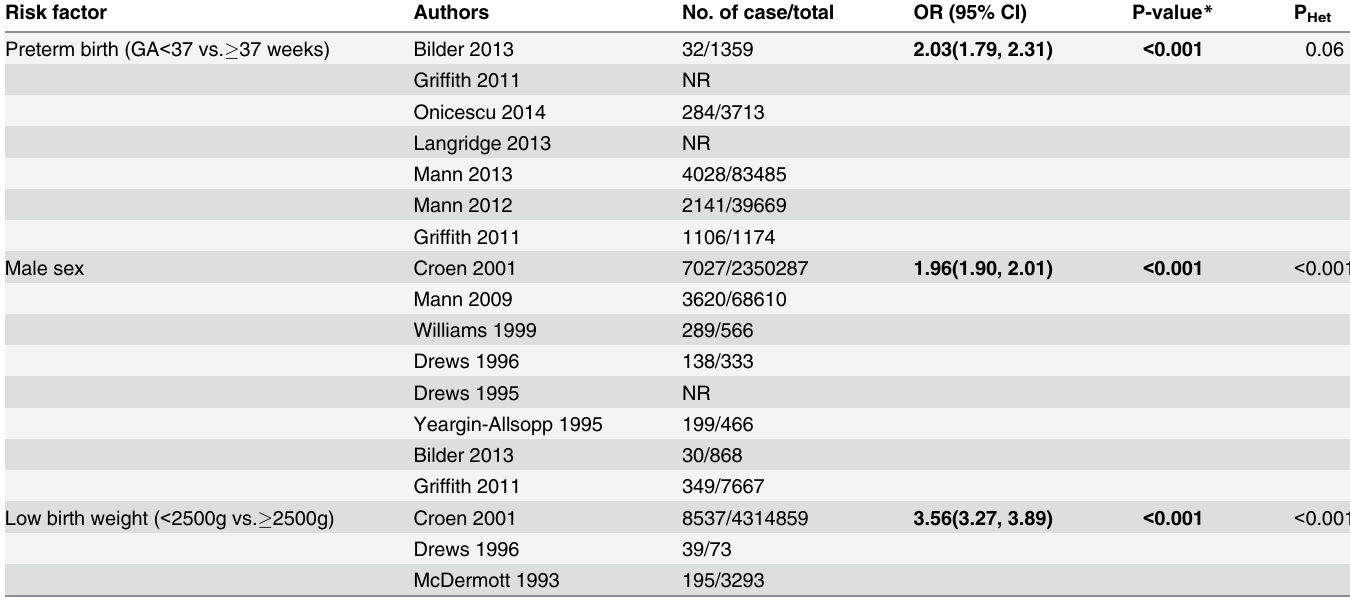
Table 4. Meta-analysis of peri- and neonatal risk factors for